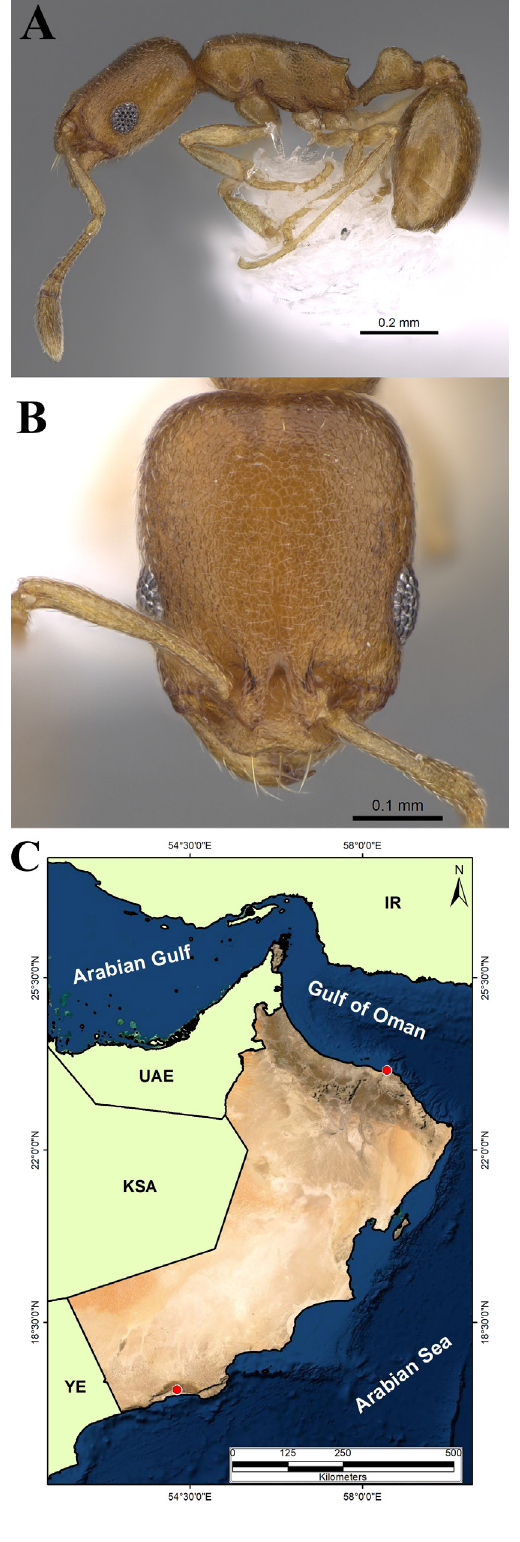
Fig. 28. Cardiocondyla yemeni Collingwood & Agosti, 1996, worker (CASENT0922874, AntWeb.org (Michele Esposito)). A . Body in profile. B . Head in full-face view. C . Distribution